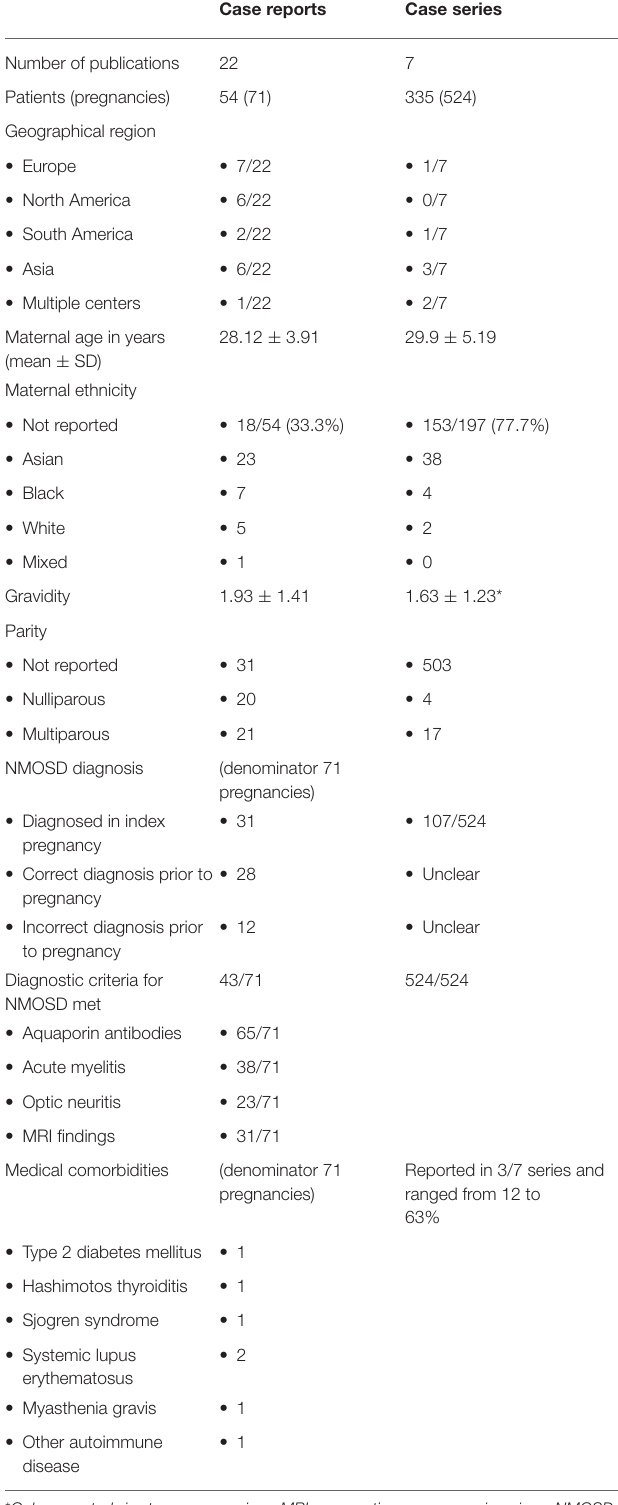
TABLE 1 | Characteristics of included publications and